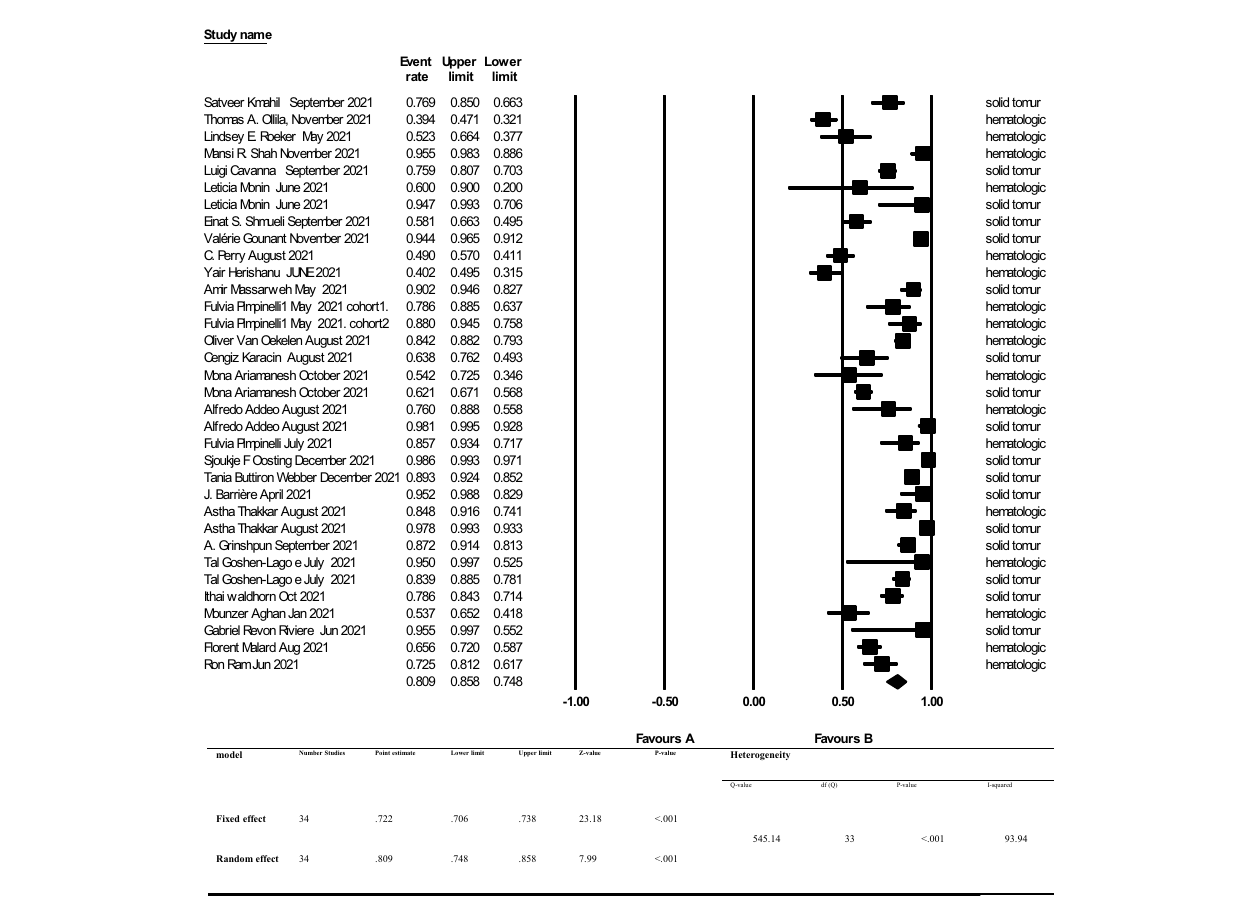
FIGURE 3 | Seroconversion rate after more than 2 weeks of receiving second dose of COVID-19 vaccine in cancer patients. Addeo et al. (25), Agha et al. (34), Ariamanesh et al. (7), Barrière et al. (29), Cavanna et al. (15), Goshen-Lago et al. (32), Gounant et al. (18), Grinshpun et al. (31), Herishanu et al. (20), Karacin et al. (24), Mahil et al. (11), Malard et al. (36), Massarweh et al. (21), Monin et al. (16), Ollila et al. (12), Oosting et al. (27), Perry et al. (19), Pimpinelli et al. (22), Pimpinelli et al. (26), Ram et al. (37), Revon-Riviere et al. (35), Roeker et al. (13), Shah et al. (14), Shmueli et al. (17), Thakkar et al. (30), van Oekelen et al. (23), Waldhorn et al. (33), Webber et al.